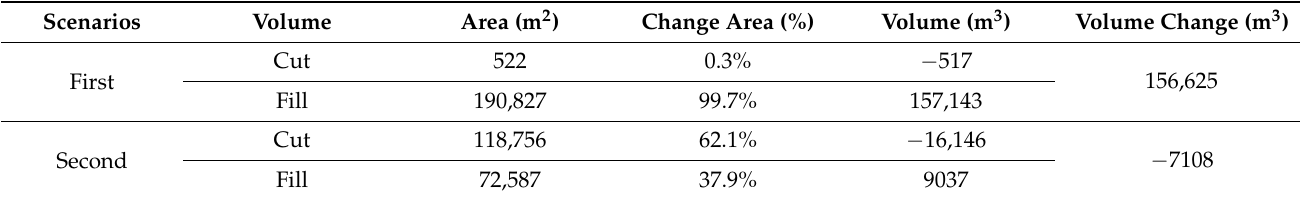
Table 10. Fill and cut volumes and change volume for the different differential DTM scenarios: First scenario—differential